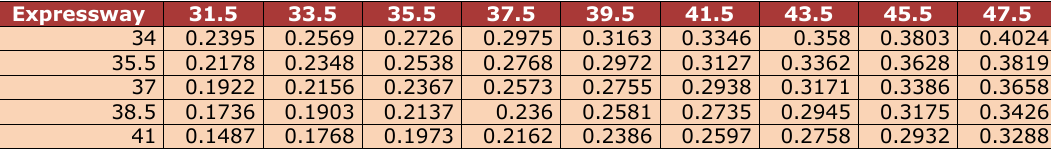
Table 4. Sharing rate of Nanchang-Jiujiang Expressway